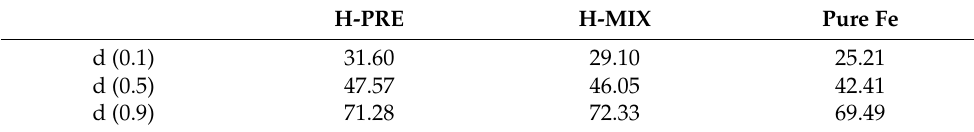
Table 3. Characteristic particle sizes of H-PRE, H-MIX, and Fe powder in µ